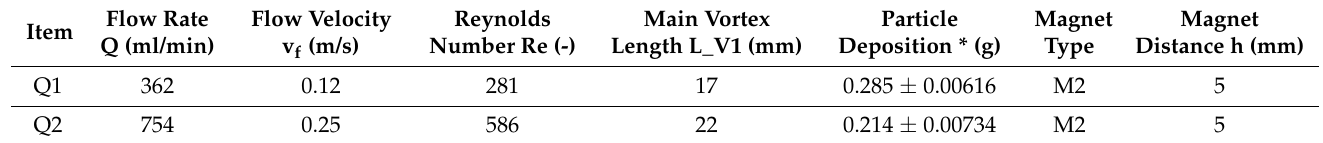
Table 9. Flow regimes and primary vortex properties.